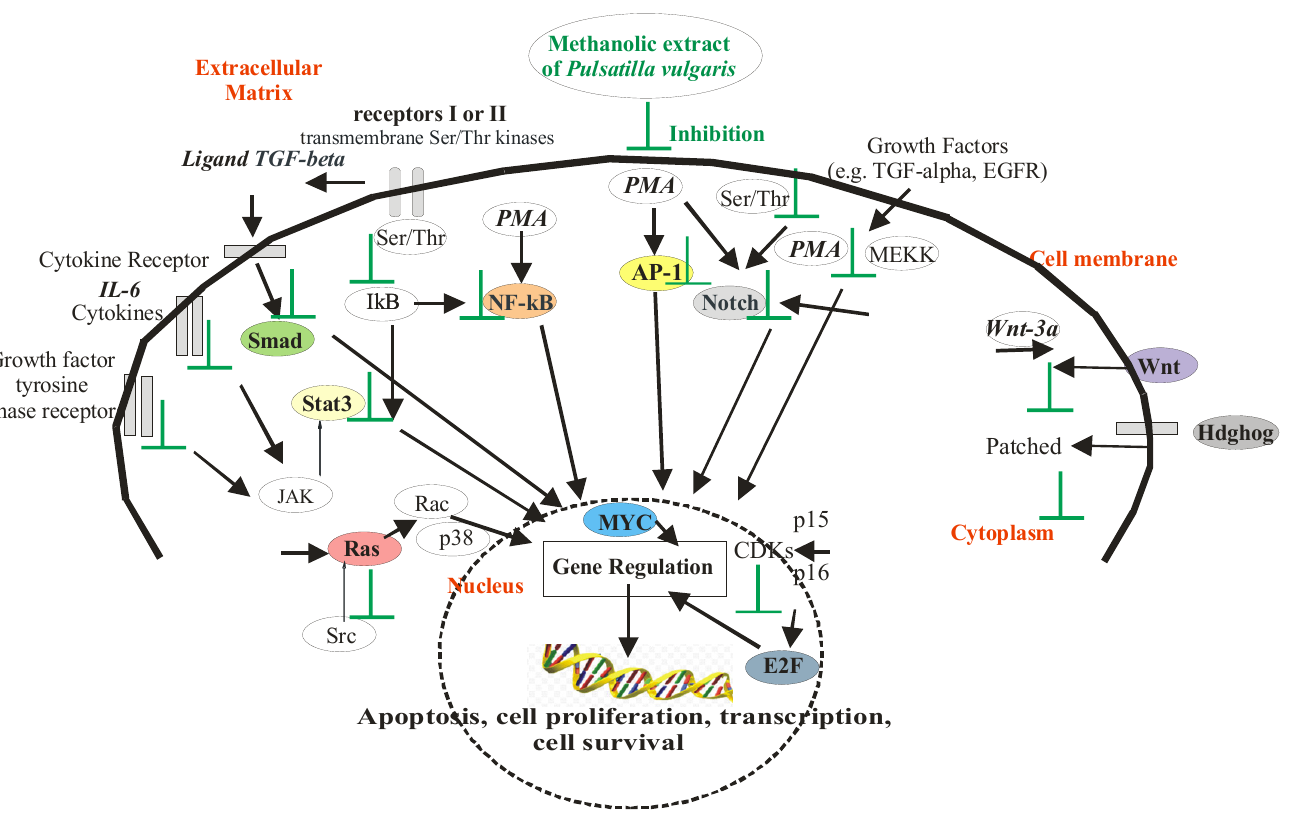
Figure 5. Oncogenic signaling pathways targets of Pulsatilla vulgaris extract. Mechanism of extract action in HeLa cells. The methanolic extracts of Pulsatilla vulgaris enhance apoptotic death, deregulated cellular proliferation, differentiation, and progression towards the neoplastic phenotype by altering key signaling molecules required for cell cycle progression [117–119]. Colors in the figure: Green captions–plant extract and inhibition mechanism; red captions–cell and its elements; Colors of transcription proteins: green–Smad, sand–Stat3 (Signal transducers and activators of transcription), yellow–AP1 (Activator protein 1), pink–Ras (Ras family kinases), violet–Wnt (WNT gene family), light grey–Notch (Neurogenic locus notch homolog protein), gray–Hdghog, blue–MYC (induced nuclear protein antigen), graphite–E2F protein, light brown–NF- κ B (nuclear factor kappa-light-chain-enhancer of activated B cells); White colors of protein kinase: PMA